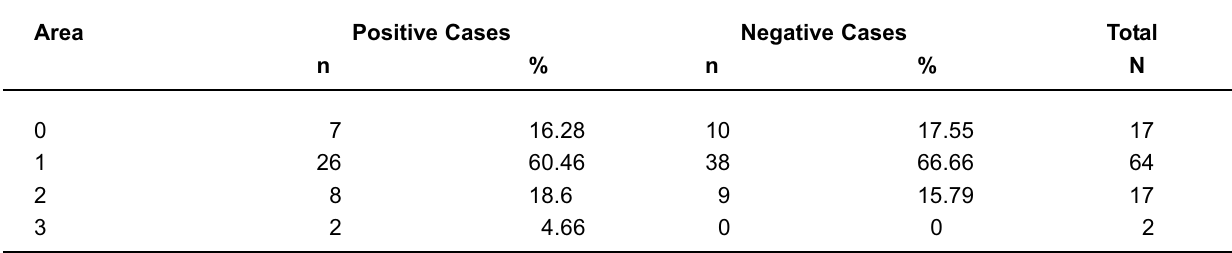
TABLE 4- Number of volunteers that presented Enterobacteriaceae, Pseudomonadaceae and Moraxellaceae on the tongue dorsum according to the tongue coating area